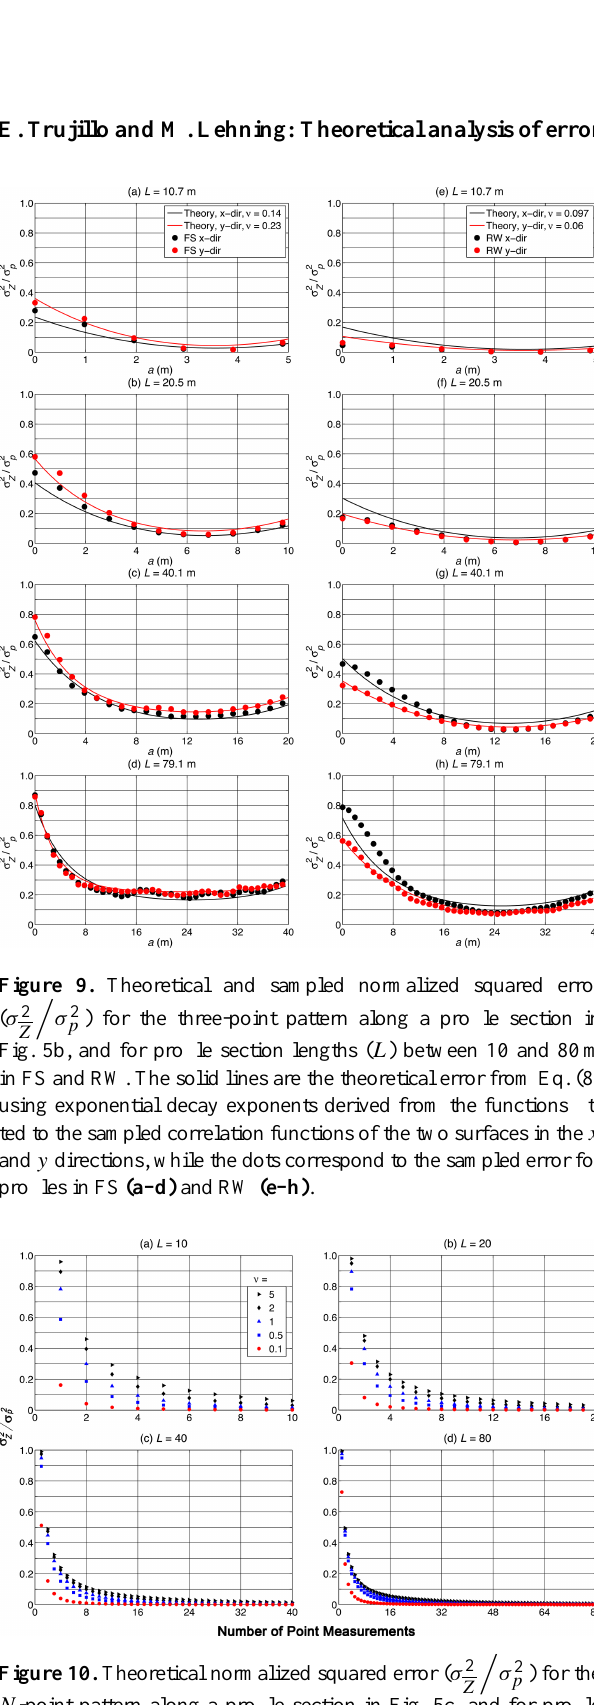
Figure 10. Theoretical normalized squared error ( σ 2 N -point pattern along a profile section in Fig. 5c, and for profile section lengths ( L ) between 10 and 80 obtained from Eq. (10).